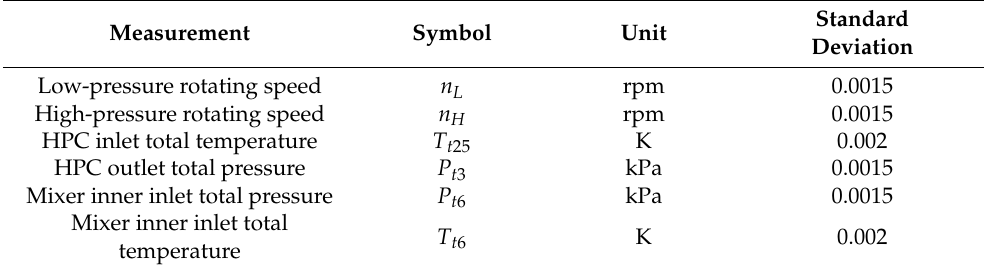
Table 1. Definition of engine’s measurable section